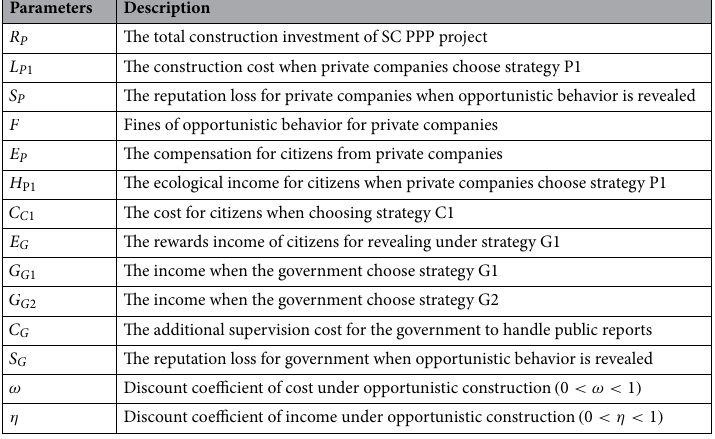
Table 1. Parameter definitions of tripartite evolutionary game model.